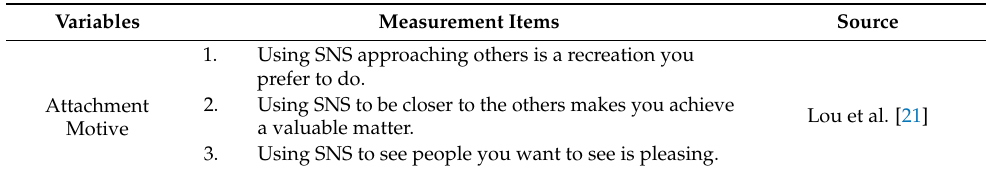
Table 1. Research variables, measurement items, and related